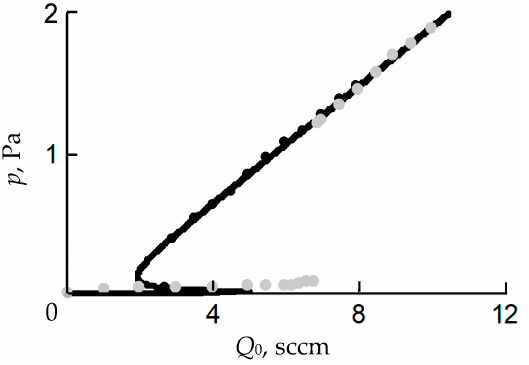
Figure 10. The result of applying the isothermal model for Ta 2 O 5 at A t = 35 cm 2 and S p = 8